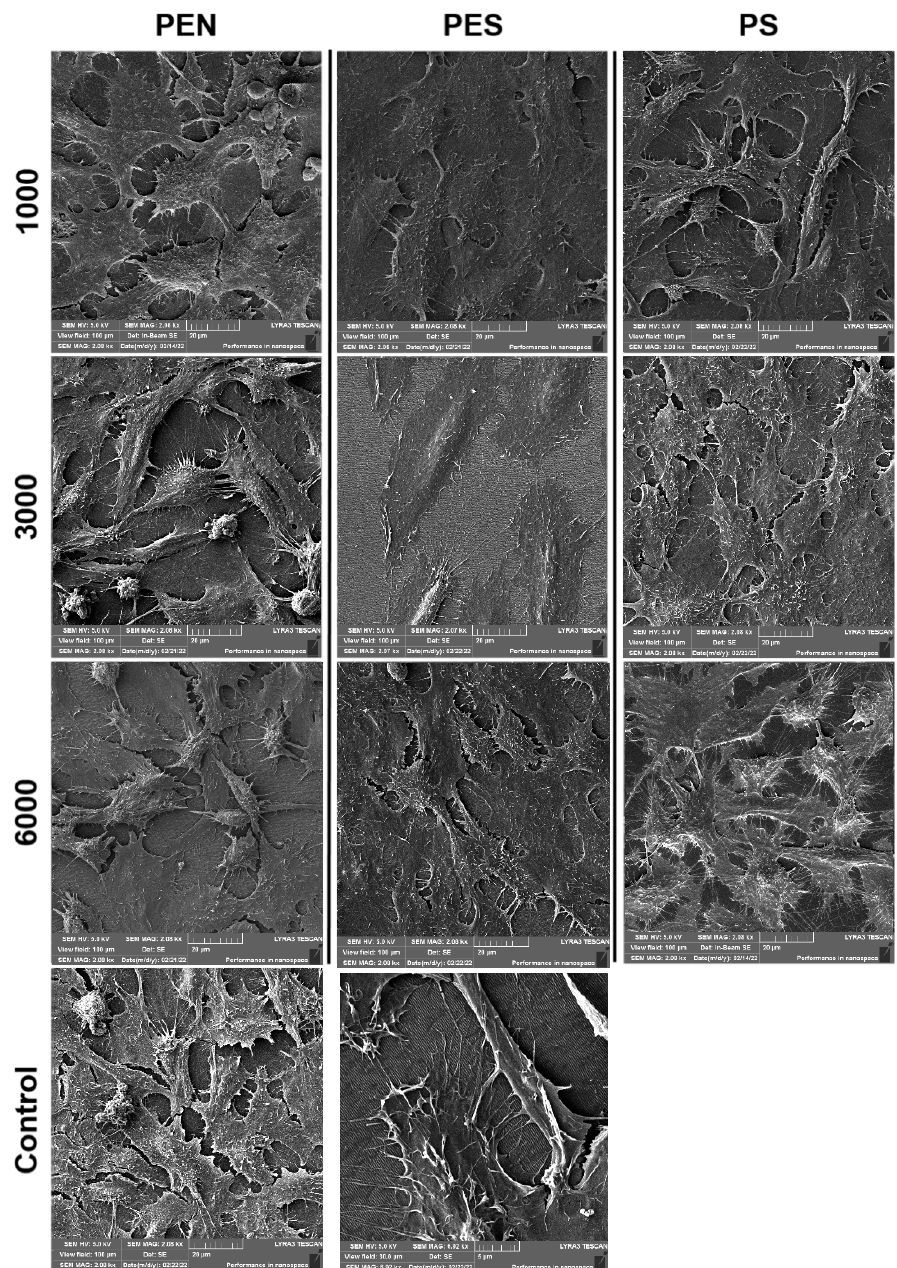
Figure 11. The SEM scans U-2 OS cells (72 h from seeding) on laser-treated PEN, PS, and PES with the fluence of 10 mJ·cm − 2 and 1000, 3000, and 6000 pulses. Tissue culture polystyrene was used as a control (KO); the control is introduced at the bottom line with two different scanned areas, 100 × 100 and 30 × 30 μ m 2 . A more detailed image for PES and 6000 pulses is introduced in the bottom right image.